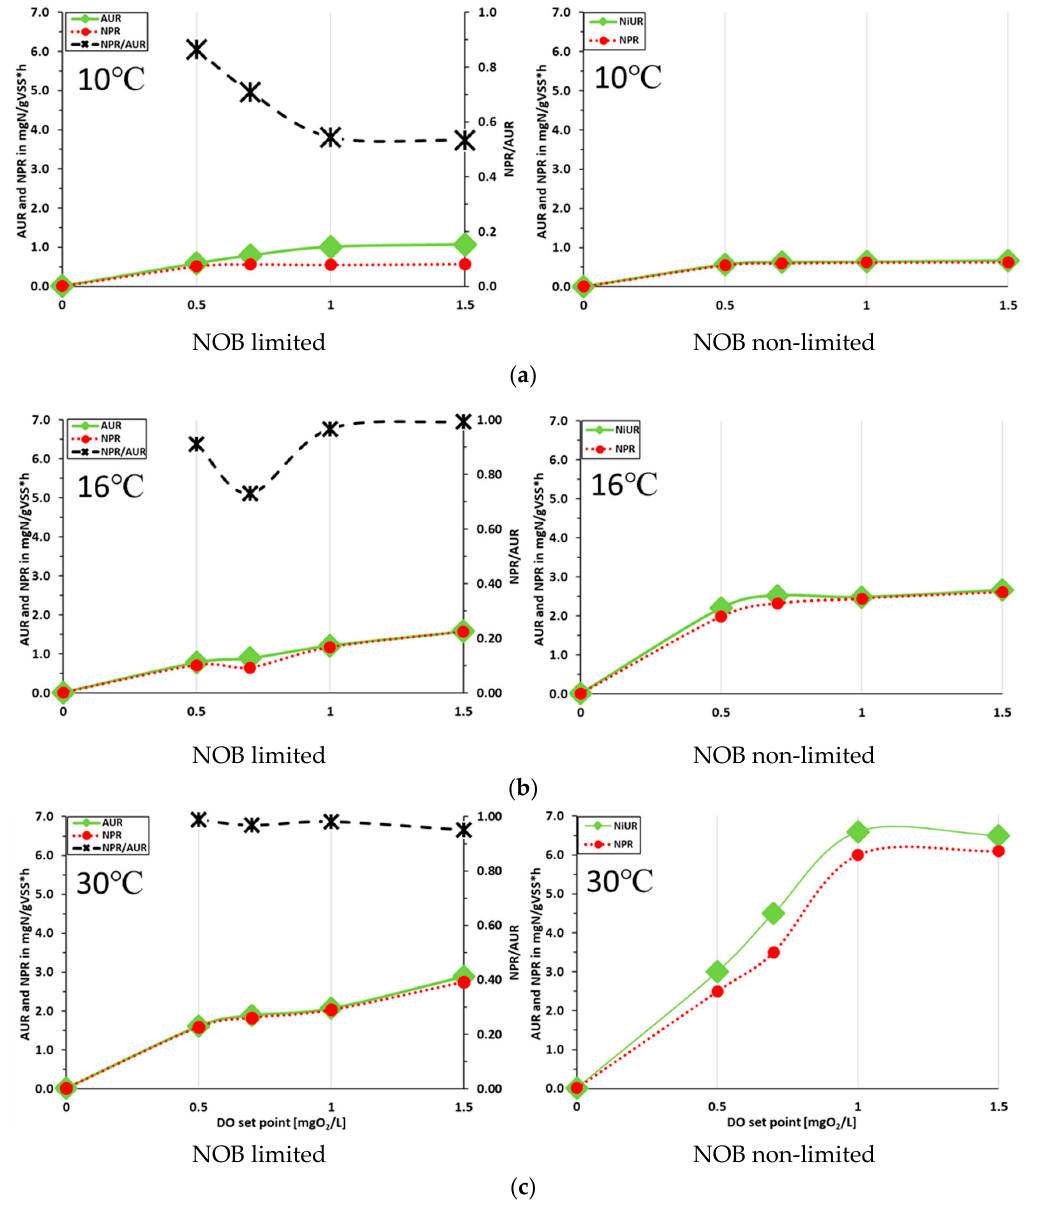
Figure 3. Comparison of the AOB and NOB activity in terms of different dissolved oxygen (DO) set points and fixed temperatures under limited (Series 1) and non-limited (Series 2) substrate availability for NOB. On the following sub-figures, measured AUR, NPR and NiUR values at the defined DO set points have been presented, under different process temperature: ( a ) 10 °C; ( b ) 16 °C; ( c ) 30 °C.